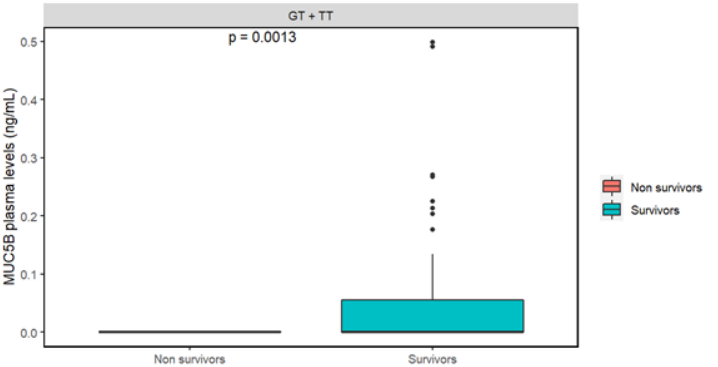
Figure 1. Concentrations of mucin 5B in plasma from patients with severe COVID-19. We employed the Mann–Whitney-U test to compare the protein level in the study